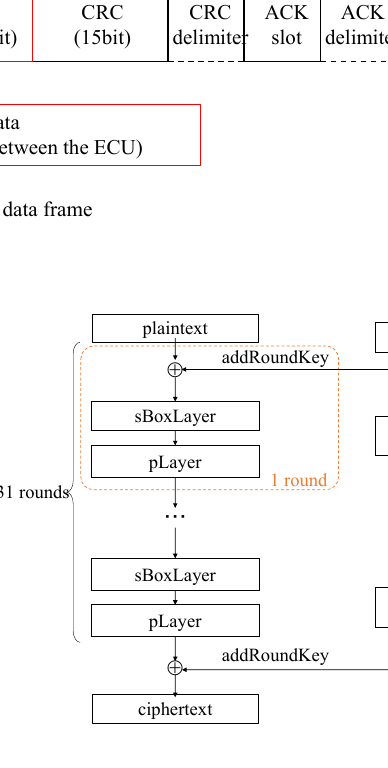
Fig. 4. Encryption processing of PRESENT